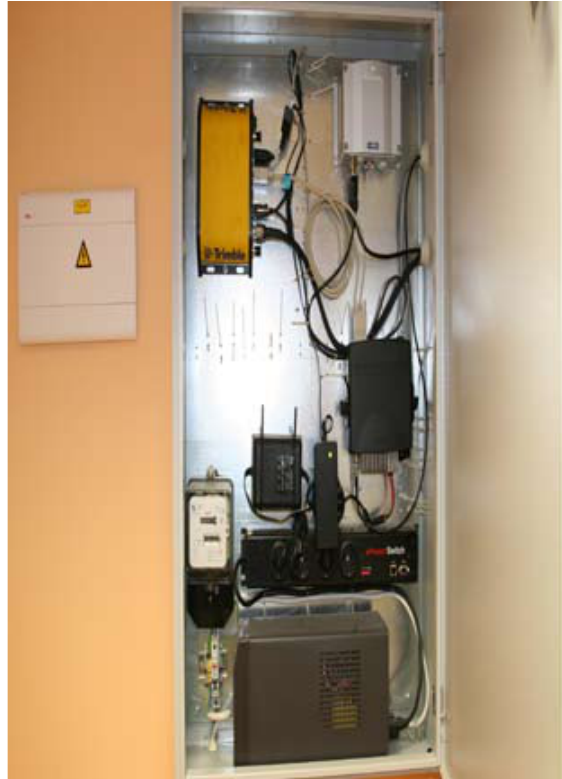
Fig. 2 . LitPOS station with Trimble NetRS